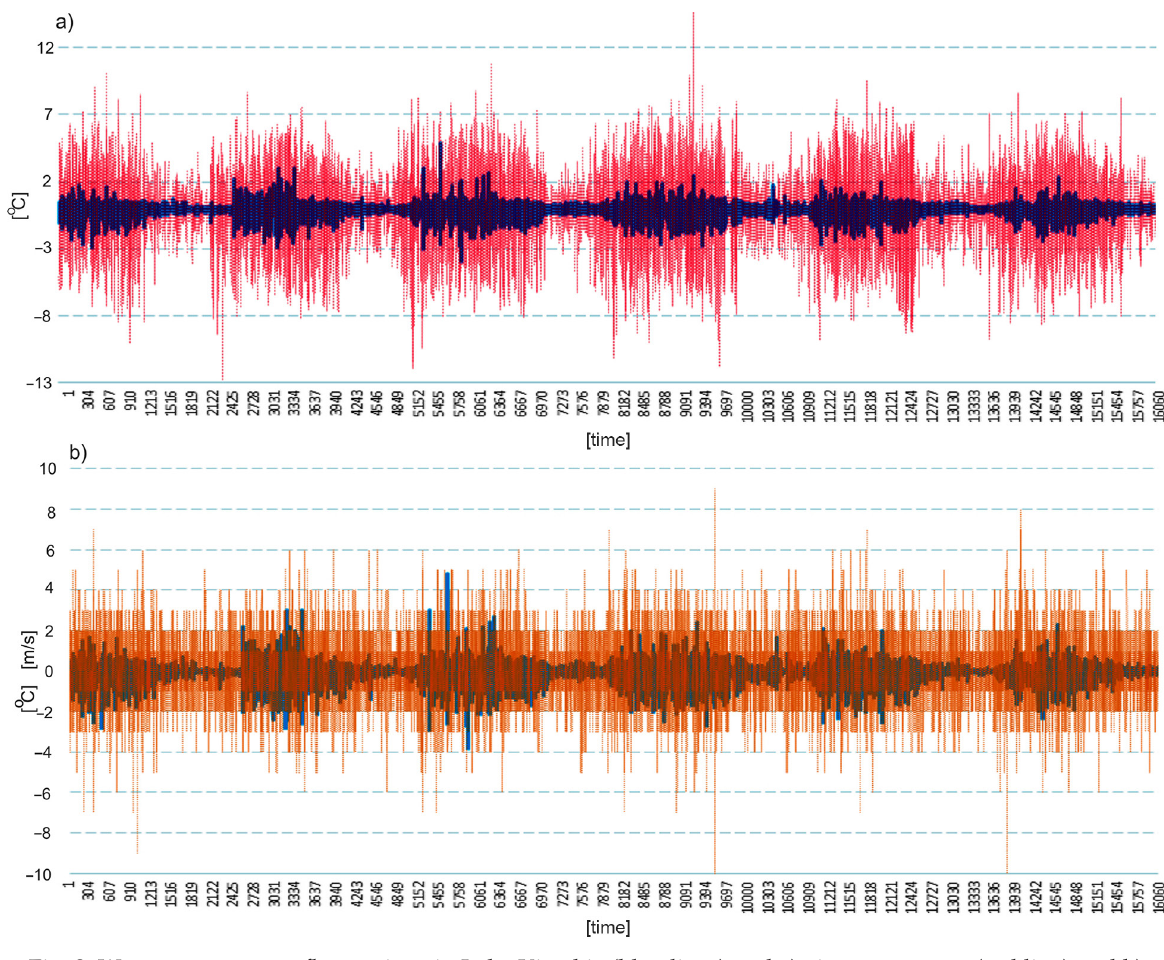
Fig. 8. Water temperature fluctuations in Lake Kierskie (blue lines) and a) air temperature (red line) and b) wind speed fluctuations (orange line) for station Poznań-ławica in 3-hours interval (May 2012–january